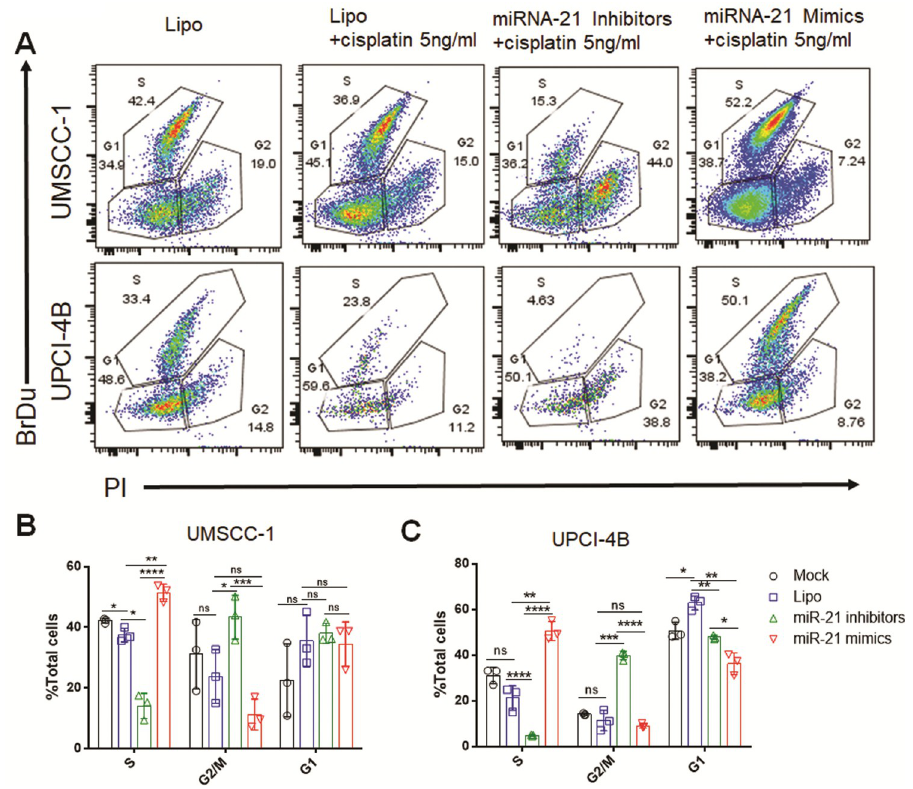
Fig 5. miR-21 can promote cell cycle progression and induce cisplatin resistance. (A) Cells were subjected to BrdU and PI double staining, and flow cytometry was used to analyse each phase of the cell cycle: cells in S phase (BrdU- positive), G2/M phases (BrdU-negative; 4N DNA content), and G1 phase (BrdU-negative; 2N DNA content). (B) and (C) In both UMSCC-1 and UPCI-4B cells treated with 5 ng/ml cisplatin during culture for 24 hours, miR-21 enhanced cell entry into S phase and induced cisplatin resistance, while the miR-21 inhibitor arrested cell cycle progression in G1, or G2, or M phase and restored cisplatin sensitivity. � , P < 0.05; �� , P < 0.01; ��� , P < 0.001; ���� , P < 0.0001. ns,